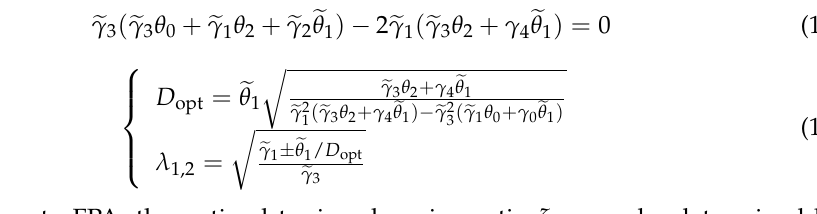
( λ 1,2 ) d D 2 ζ = 0, as shown in d = ζ d ∞ d λ